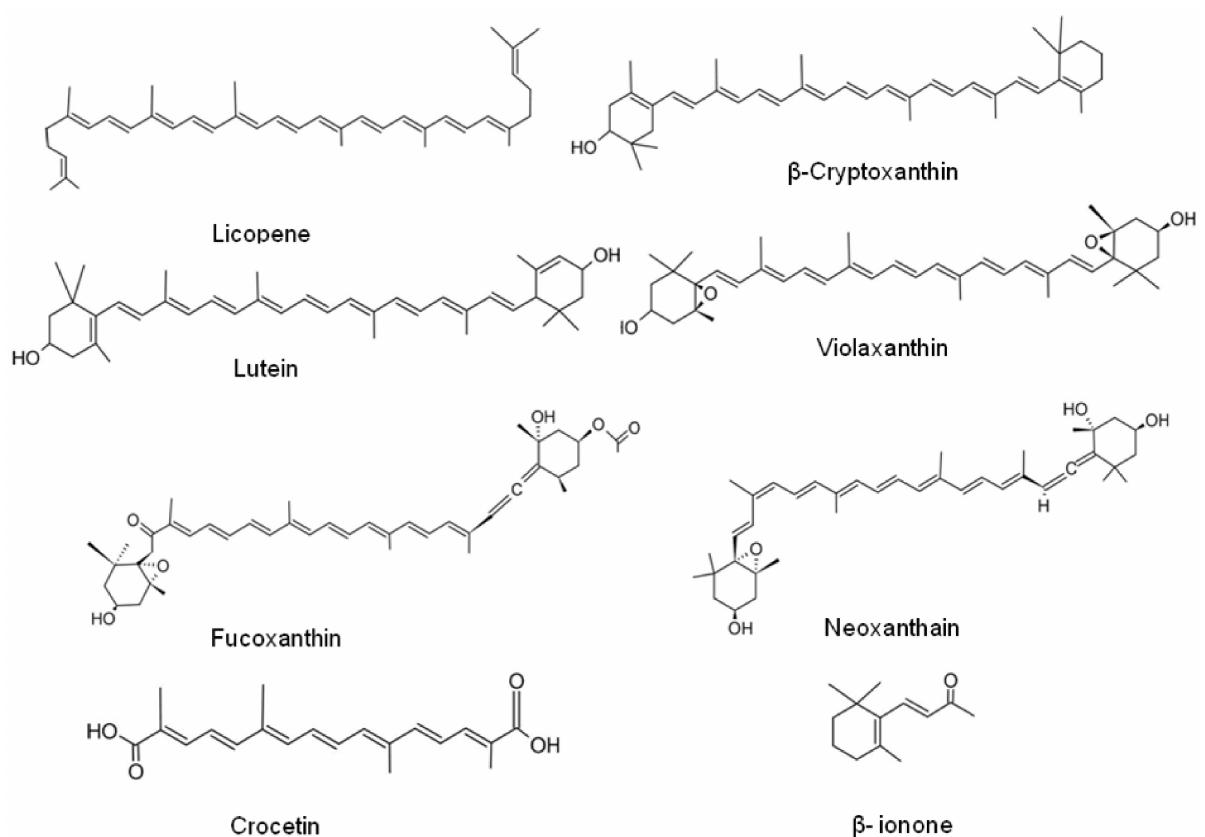
Figure 6. Chemical structures of some lead